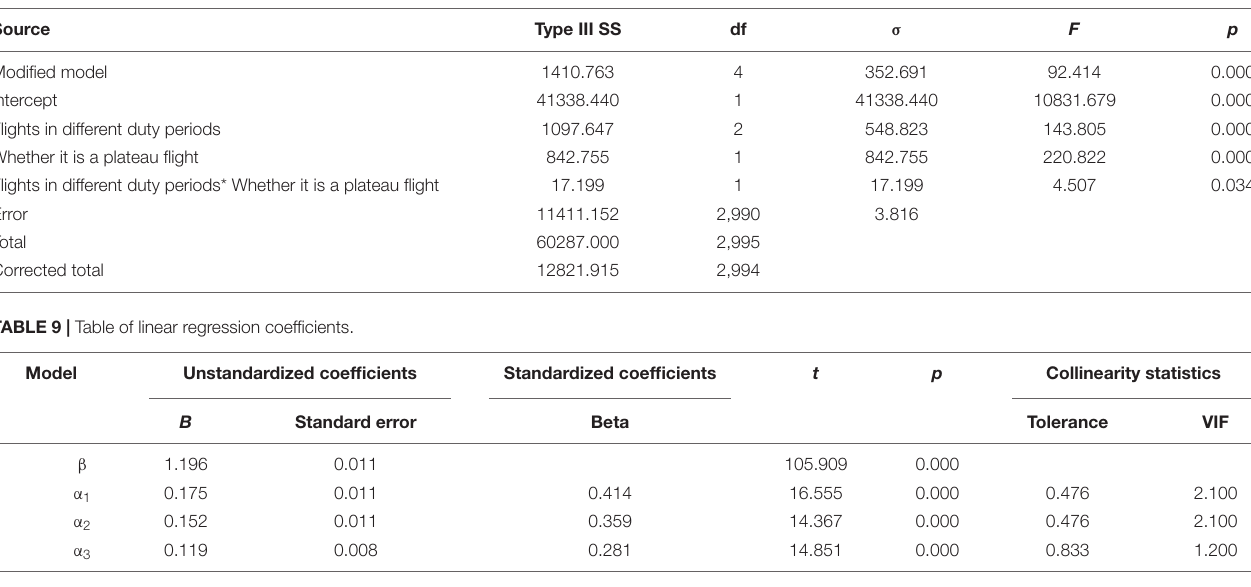
TABLE 8 | Multi-factor ANOVA between-subjects effect test.